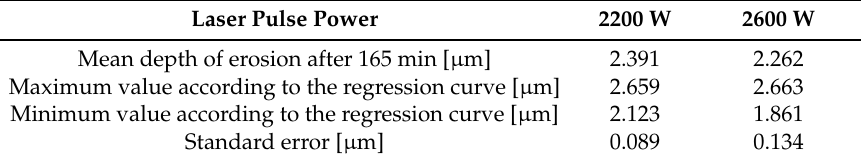
Table 3. The values of the statistical parameters for the cavitation erosion experiments.